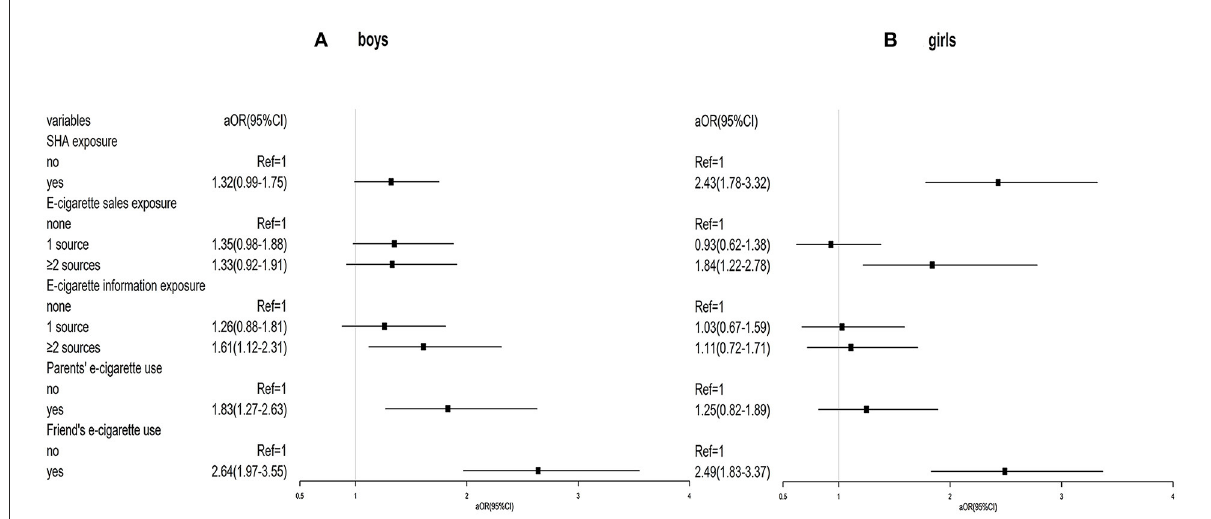
FIGURE1 (A,B) Stratification of association between social-environmental exposure and e-cigarette use by gender.